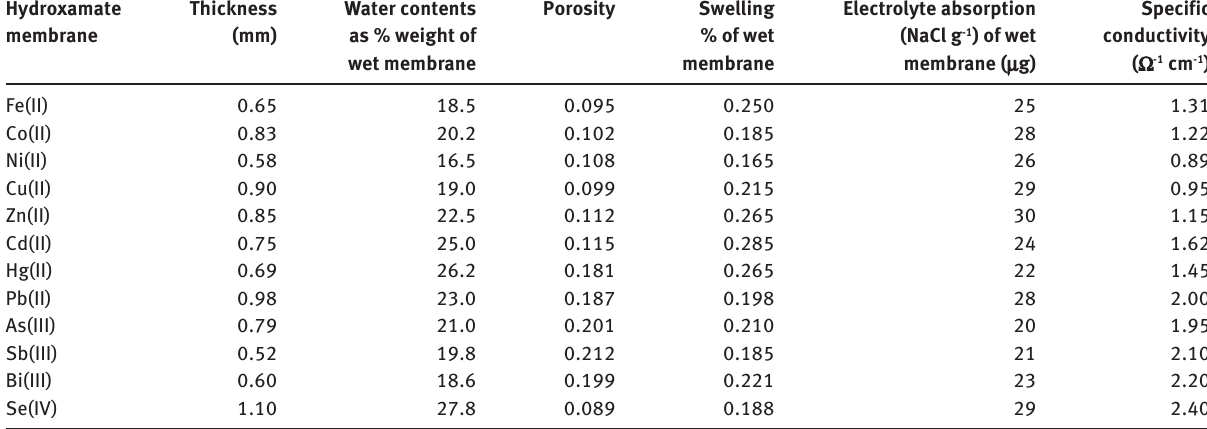
Table 2 Characteristics of the